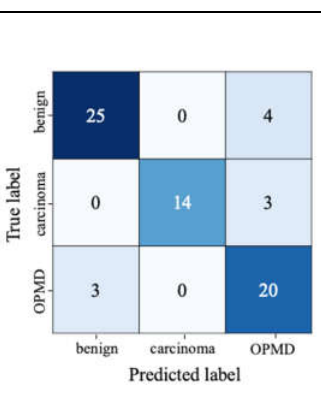
Figure 5. Confusion matrix for the EfficientNet-b4 model on the test set. The values on the diagonal